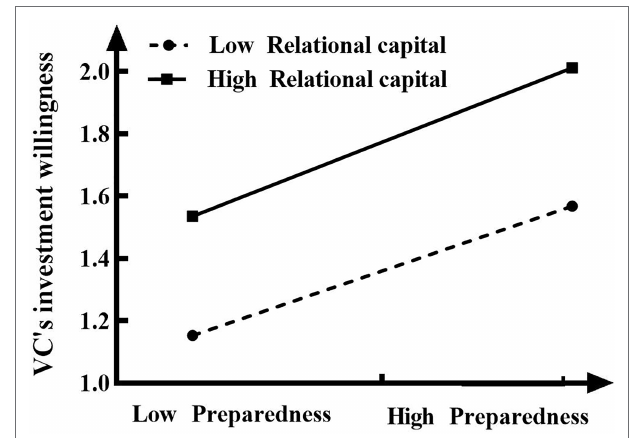
FIGURE 2 | Interactive effect of the relational capital and entrepreneurial preparedness on venture capitalists’ willingness to